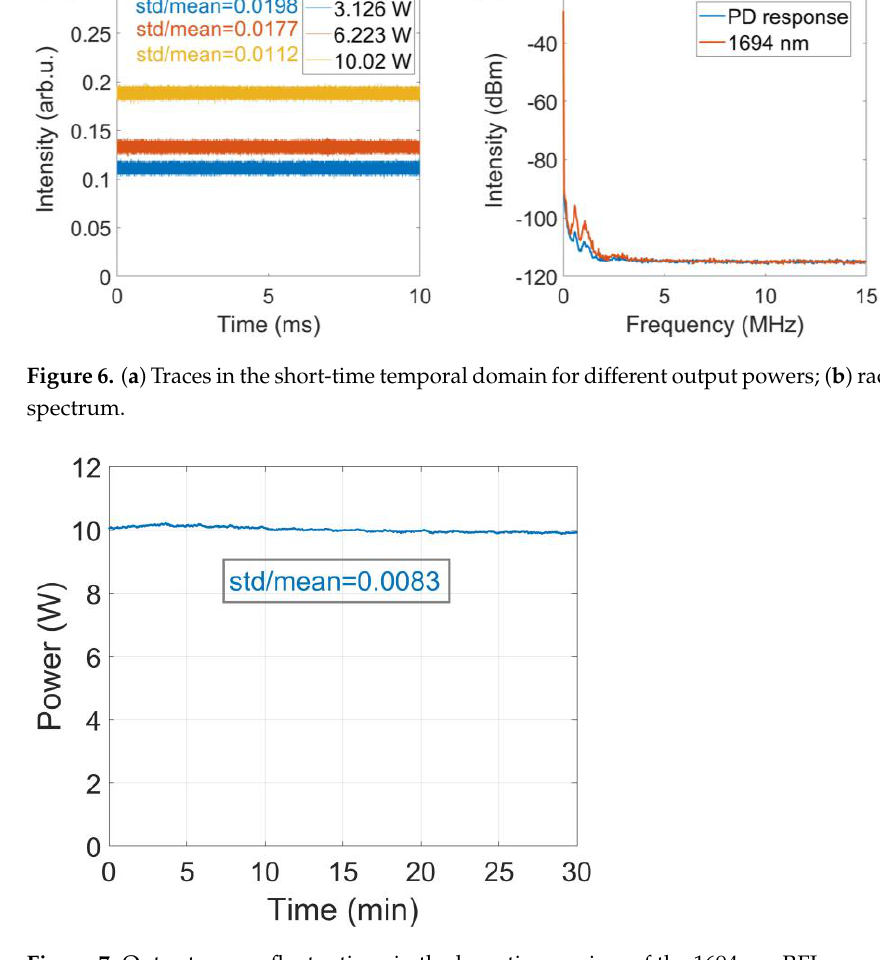
Figure 7. Output power fluctuations in the long-time regime of the 1694 nm RFL.